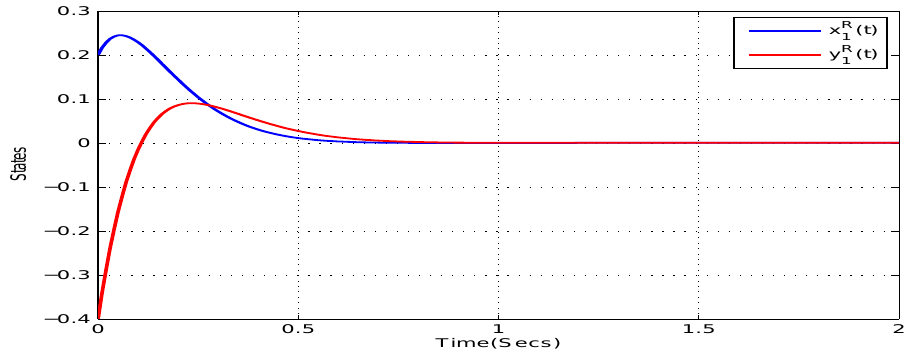
Figure 3. An illustration of the time responses with respect to the real part pertaining to the states of ( t ) , y R ( t ) in Example x R 1 1